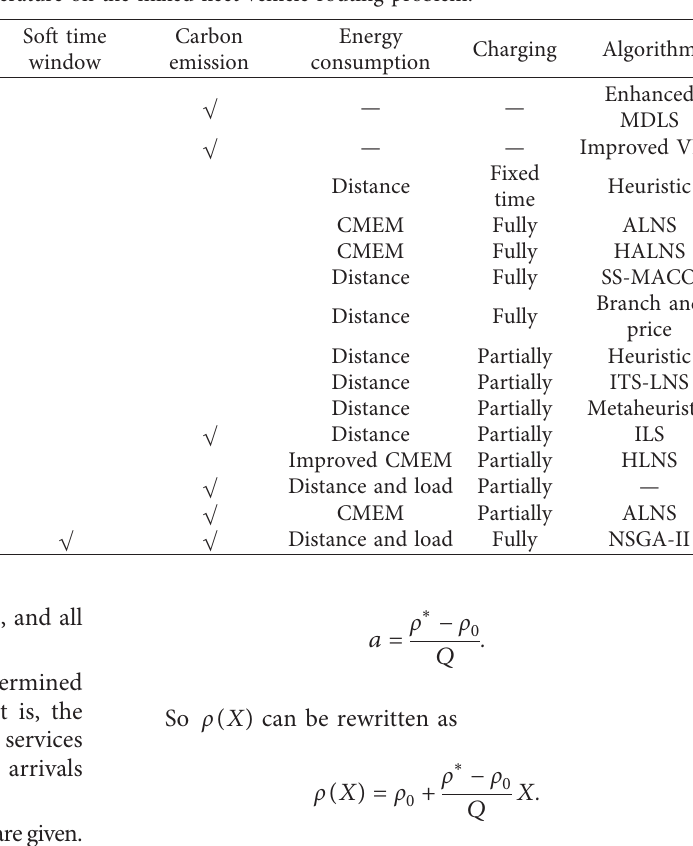
Table 1: Summary of the literature on the mixed fleet vehicle routing